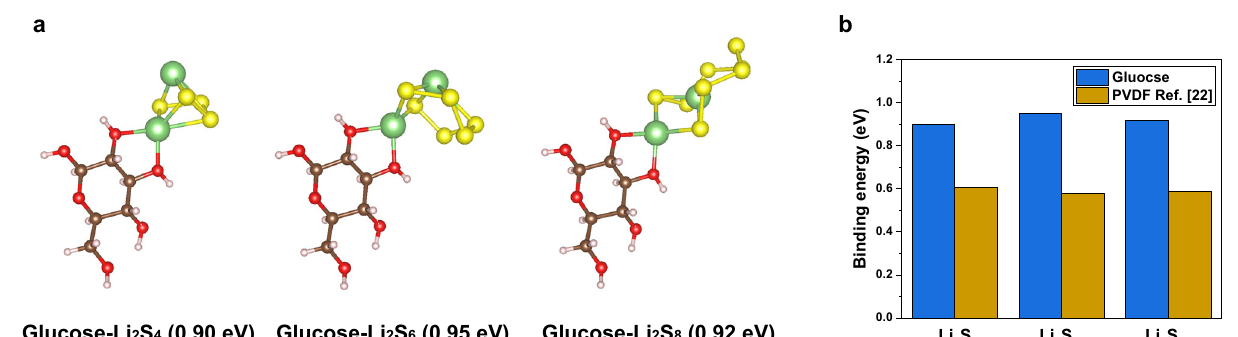
Fig. 1 Simulation of LiPS adsorption. a Adsorption conformations and binding energies for Li 2 S 4 , Li 2 S 6 , and Li 2 S 8 on glucose. b Binding energy comparison for glucose and the commonly used PVDF binder 22 with various LiPS species, demonstrating the capacity of glucose for adsorbing polysul